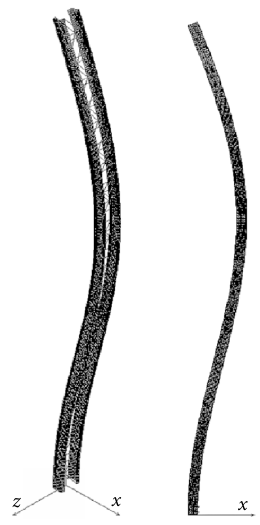
Fig. 3. Three situations of the buckling analysis of the column